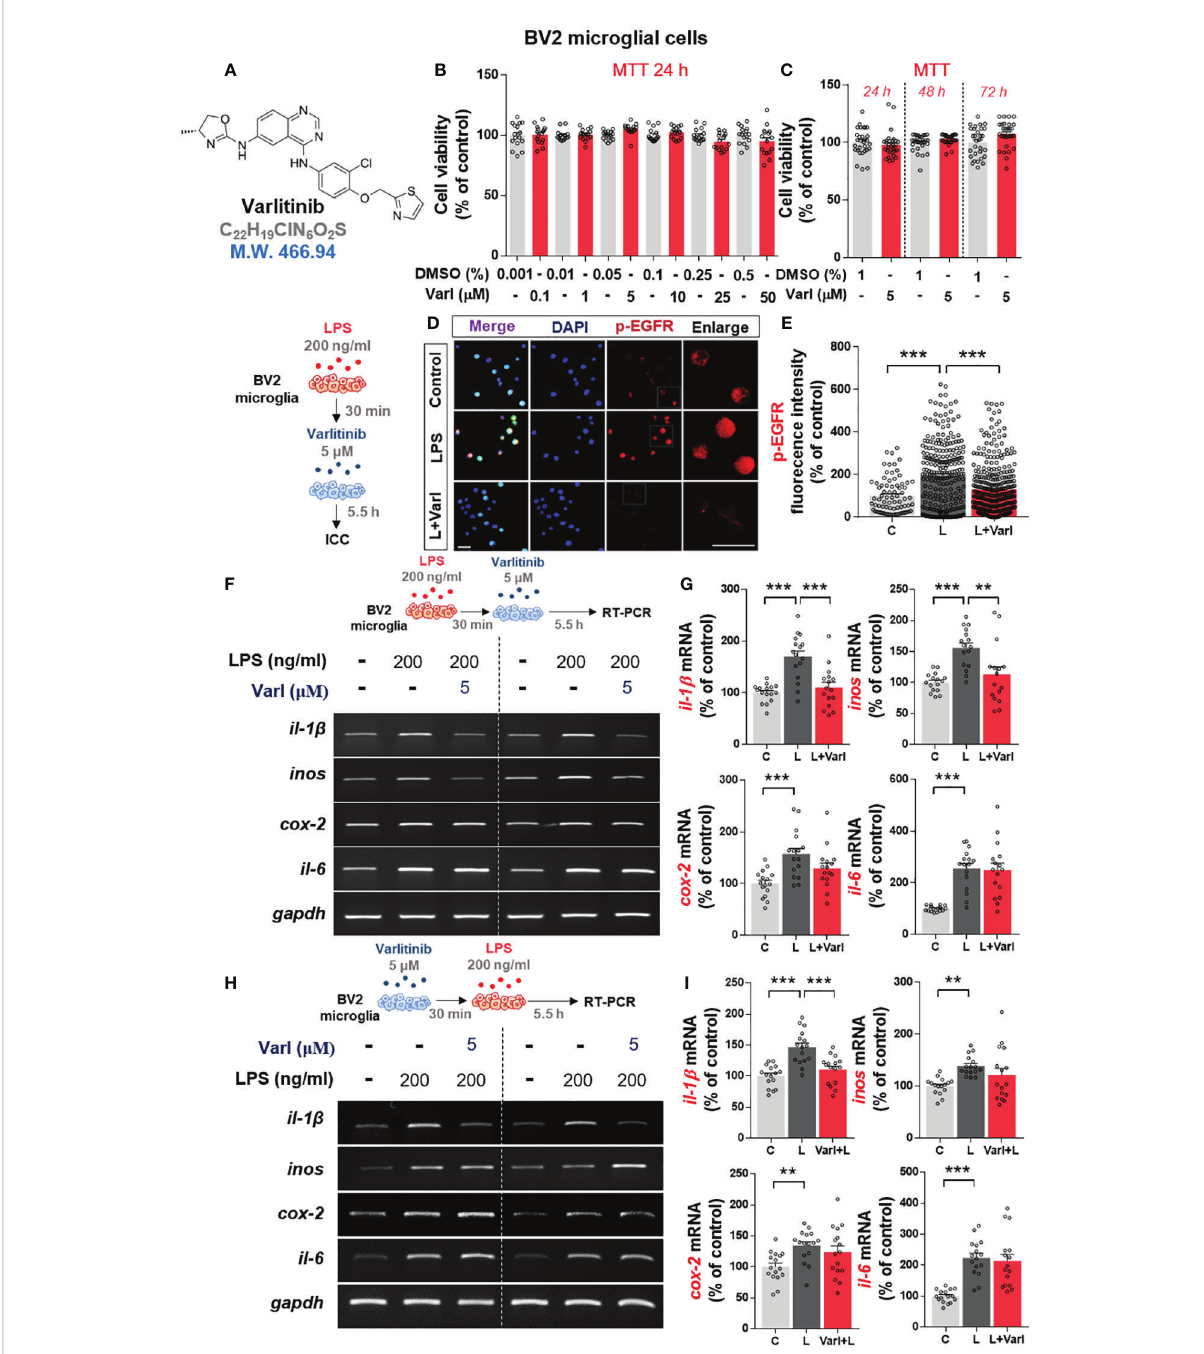
FIGURE 1 Varlitinib diminishes LPS-induced proin fl ammatory cytokine and mediator mRNA expression in BV2 microglial cells. (A) Structure of varlitinib. (B) Cells were treated with vehicle (DMSO) or varlitinib (0.1, 1, 5, 10, 25, 50 m M) for 24 h, and MTT assays were conducted (n = 16/group, 2 experimental replicates per dose). (C) Cells were treated with vehicle (1% DMSO) or varlitinib (5 m M) for 24 h, 48 h, and 72 h, and MTT assays were conducted (n = 30/group). (D, E) Cells were treated with LPS (200 ng/ml) or PBS for 30 min and varlitinib (5 m M) or vehicle (1% DMSO) for 5.5 h, and immunocytochemistry was conducted with anti-p-EGFR antibodies (C: n = 77; L: n = 263; L+Varl: n = 354, total number of examined cells). (F, G) Cells were treated as in (D, E) , and proin fl ammatory cytokine and inos mRNA levels were measured by RT-PCR ( il-1 b , inos, cox-2 , and il-6 : C: n = 16; L: n = 16; L+Varl: n = 16, independent biological replicates, 3 experimental replicates per group). (H, I) Cells were treated with varlitinib (5 m M) or vehicle (1% DMSO) for 30 min and LPS (200 ng/ml) or PBS for 5.5 h, and proin fl ammatory cytokine and inos mRNA levels were measured by RT-PCR ( il-1 b , inos, cox-2 , and il-6 : C: n = 16; L: n = 16; L+Varl: n = 16, independent biological replicates, 3 experimental replicates per group). ** p < 0.01, *** p < 0.001, C: Control; L: LPS; L+Varl: LPS+Varlitinib. Scale bar = 20 m